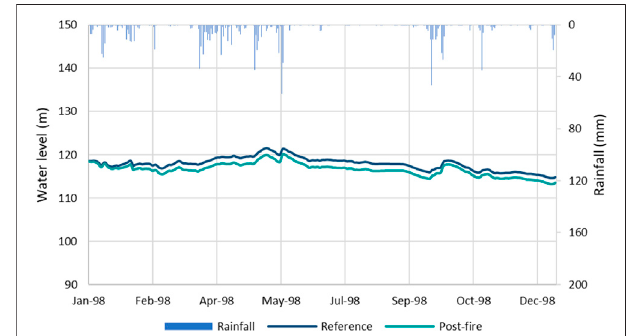
FIGURE 7 | Water level comparison between the post- fi re and the reference